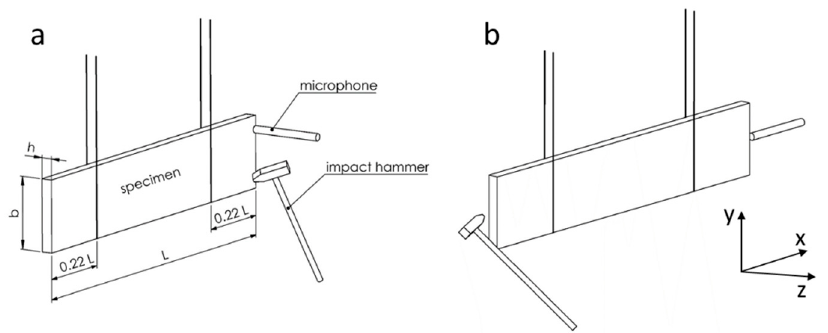
Figure 3. Experimental system for determination of natural frequencies: ( a ) flexural and torsional vibration; ( b ) longitudinal vibration.